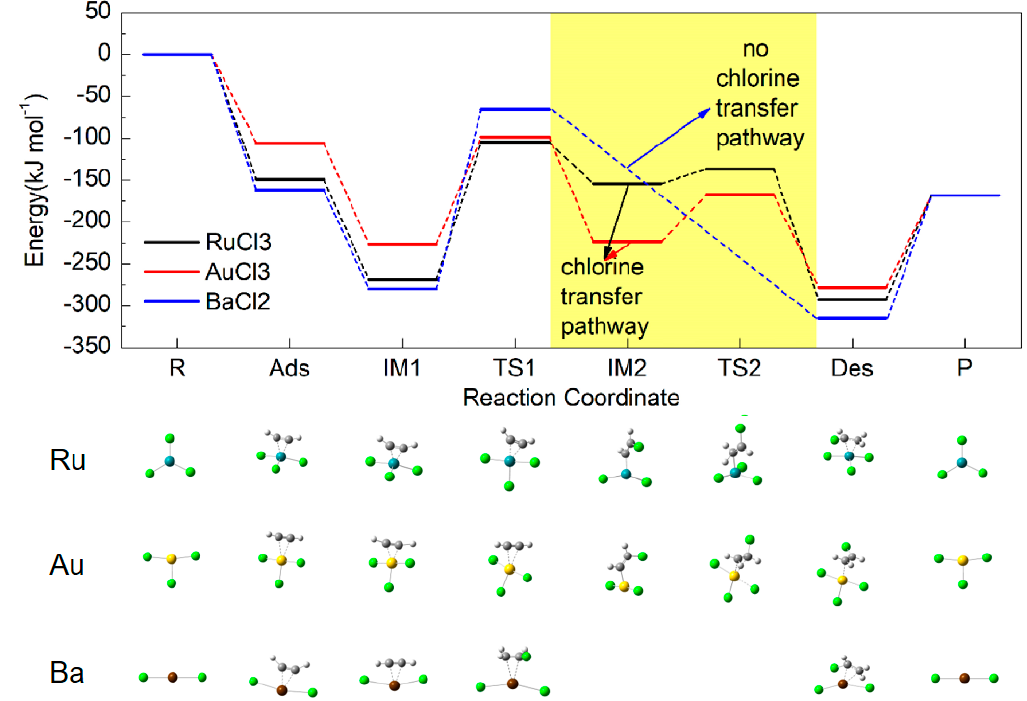
Figure 5. Energy profiles and corresponding structures of species for acetylene hydrochlorination reaction. Free molecules of C 2 H 2 , HCl, and VCM are omitted for clarity.